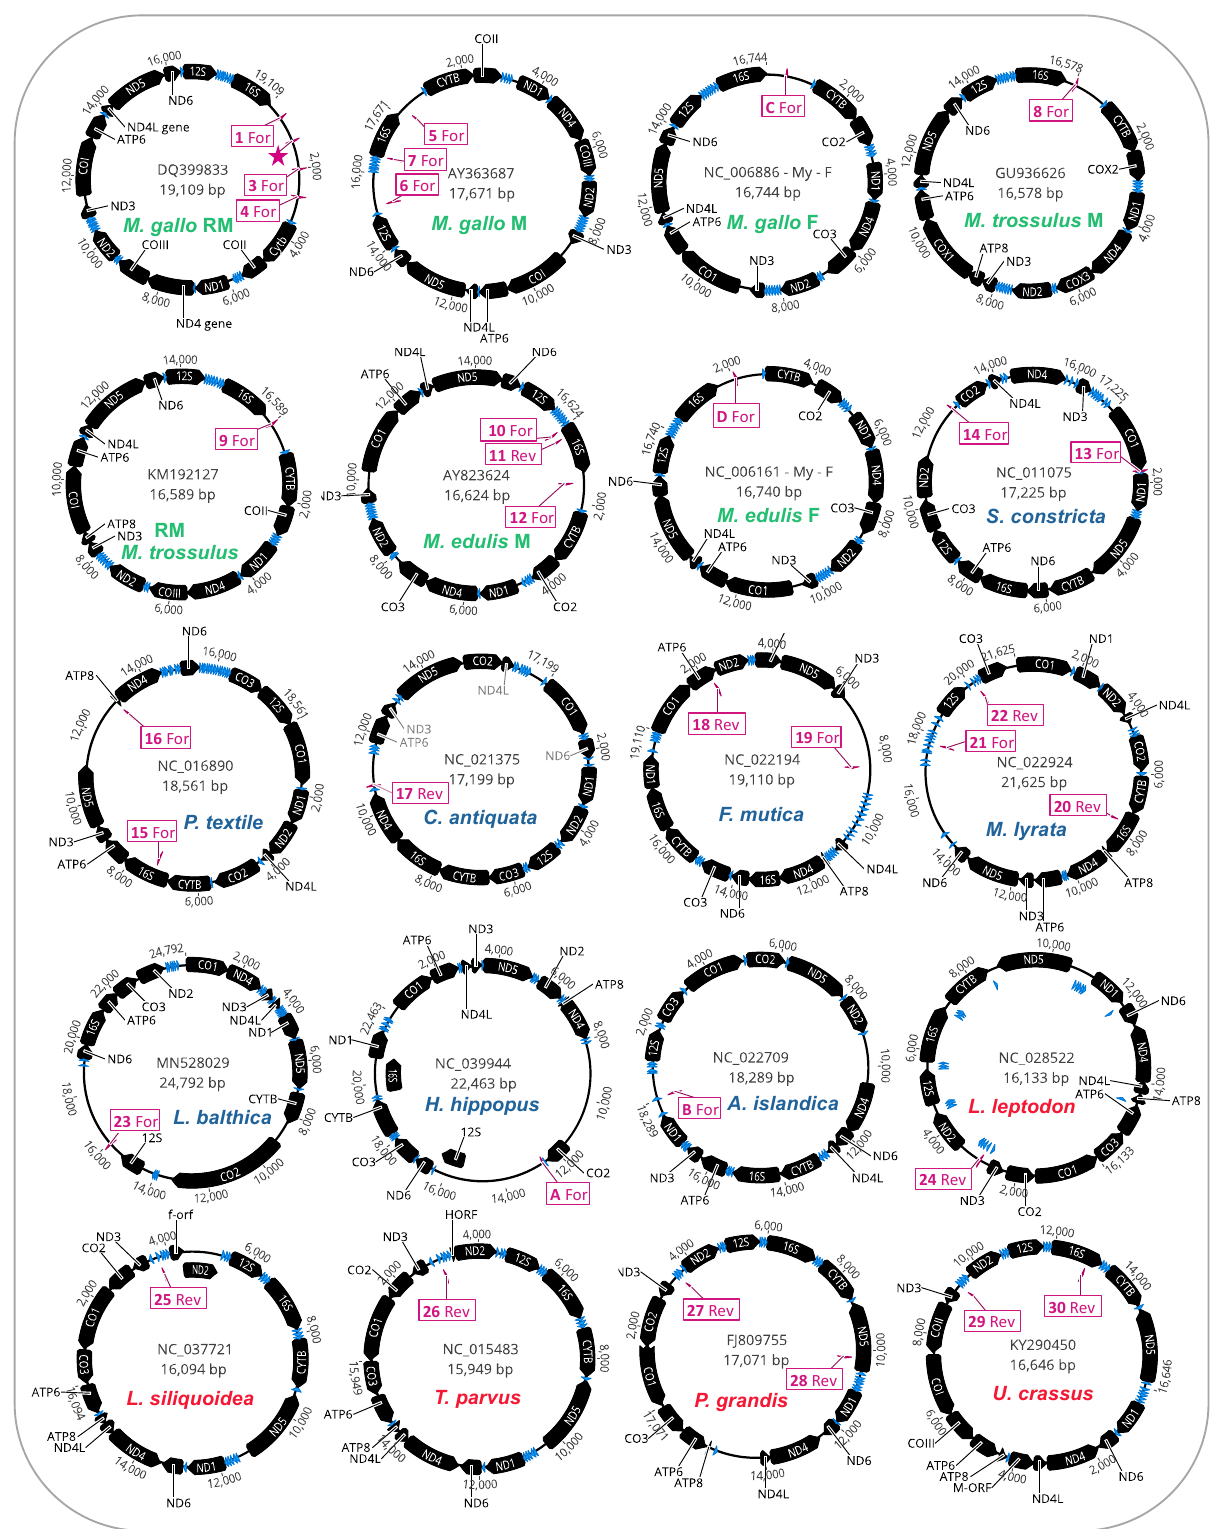
Figure 3. Mitochondrial genome maps for bivalve species exhibiting putative STE motifs localized to large unassigned regions in mtDNA. STE ‐ like signatures are identified by map codes within boxes (these correspond to codes in Figure 1c) and can either be found on the Reverse (Rev) or Forward (For) mtDNA orientation. M. gallo refers to M. galloprovincialis .